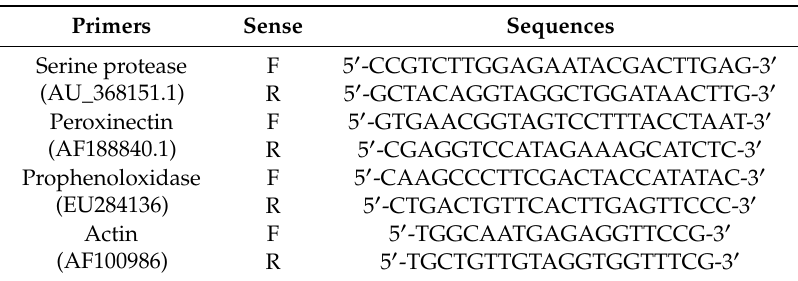
Table 2. Primers used to quantify relative gene